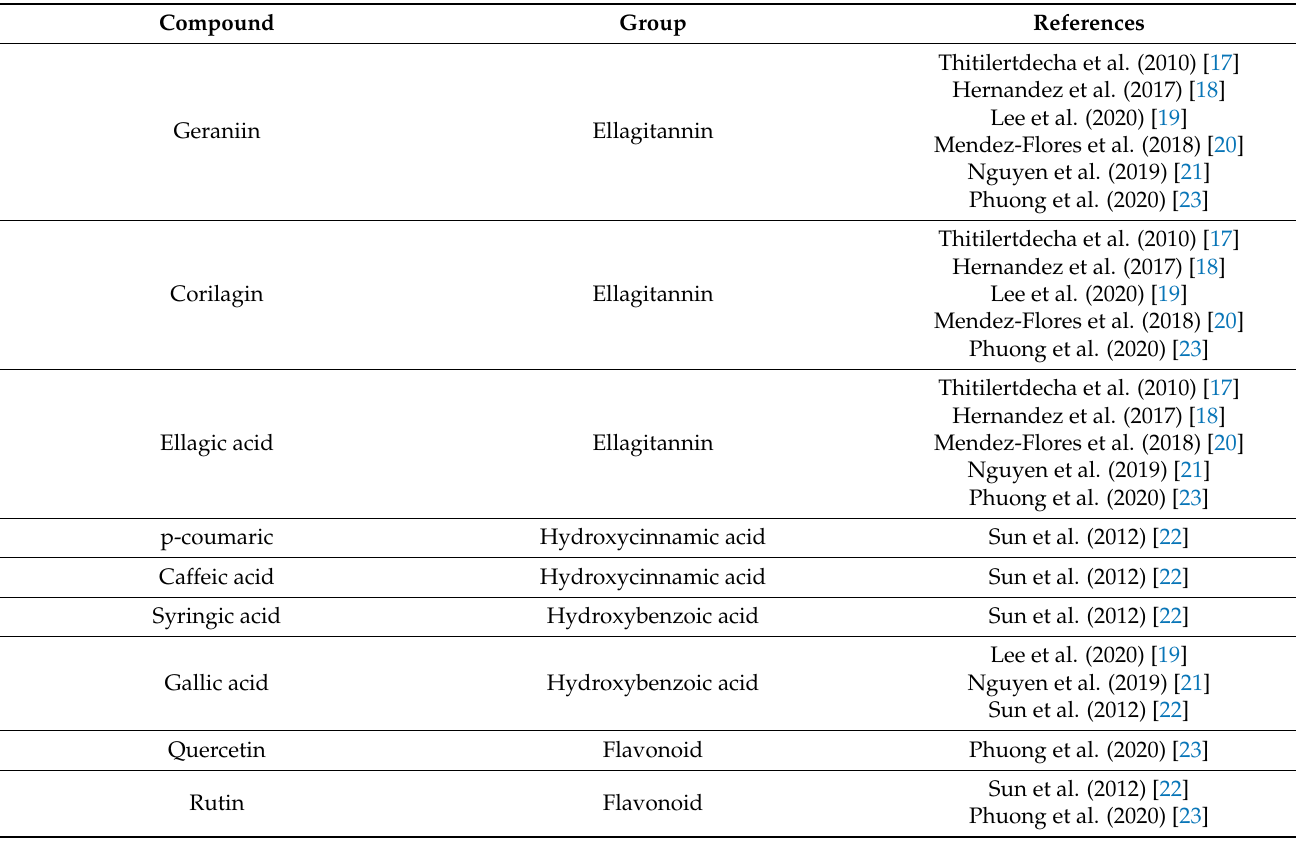
Table 1. Bioactive compounds from N. lappaceum